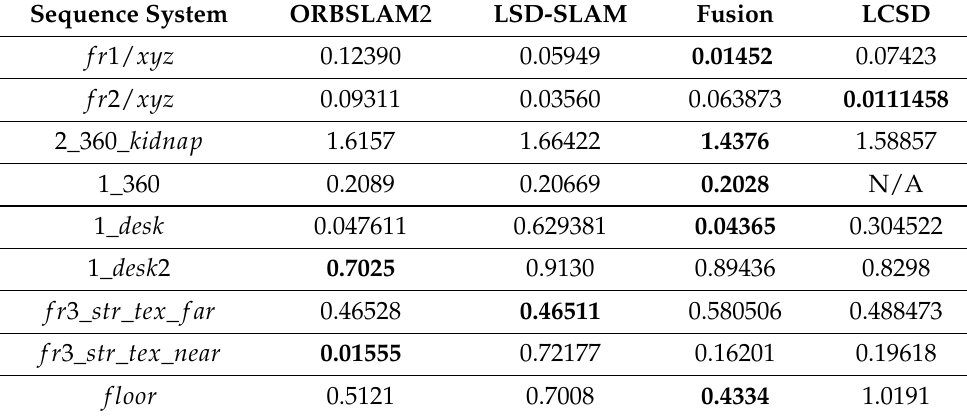
Table 1. RMSE of the four systems on sequences of the TUM database (best results in bold). N/A means the system has failed to initialize or was lost for more than 50% of the scene. The values represent the mean over five passes of each